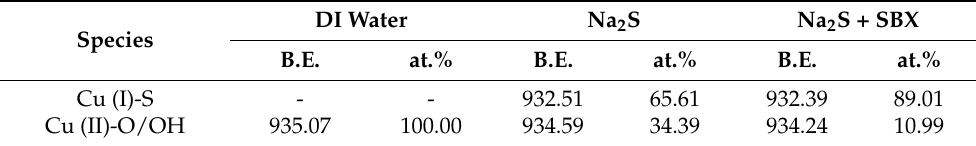
Figure 9. Fitting peaks of Fe 2p ( a ), Cu 2p ( b ), and S 2p ( c ) for digenite with different treatments in the presence of Fe 3+ (pH: 7.0; Fe 3+ dosage: 1 × 10 − 3 mol/L; Na 2 S dosage: 1.25 × 10 − 3 mol/L; SBX dosage: 1 × 10 − 4 mol/L). Table 1. Cu 2p quantification of digenite with different treatments in the absence of Fe 3+ . Table 3. Fe 2p quantification of digenite with different treatments in the presence of Fe 3+ .